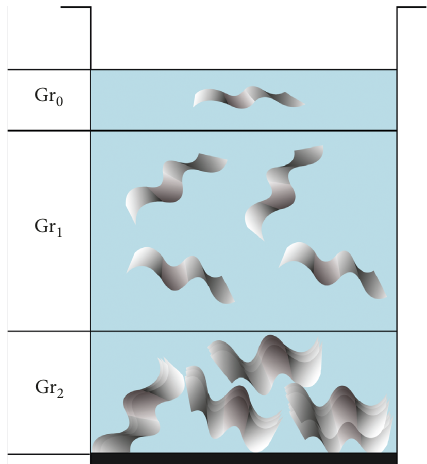
Figure 2: Stratification of a graphene suspension and its stepped decantation